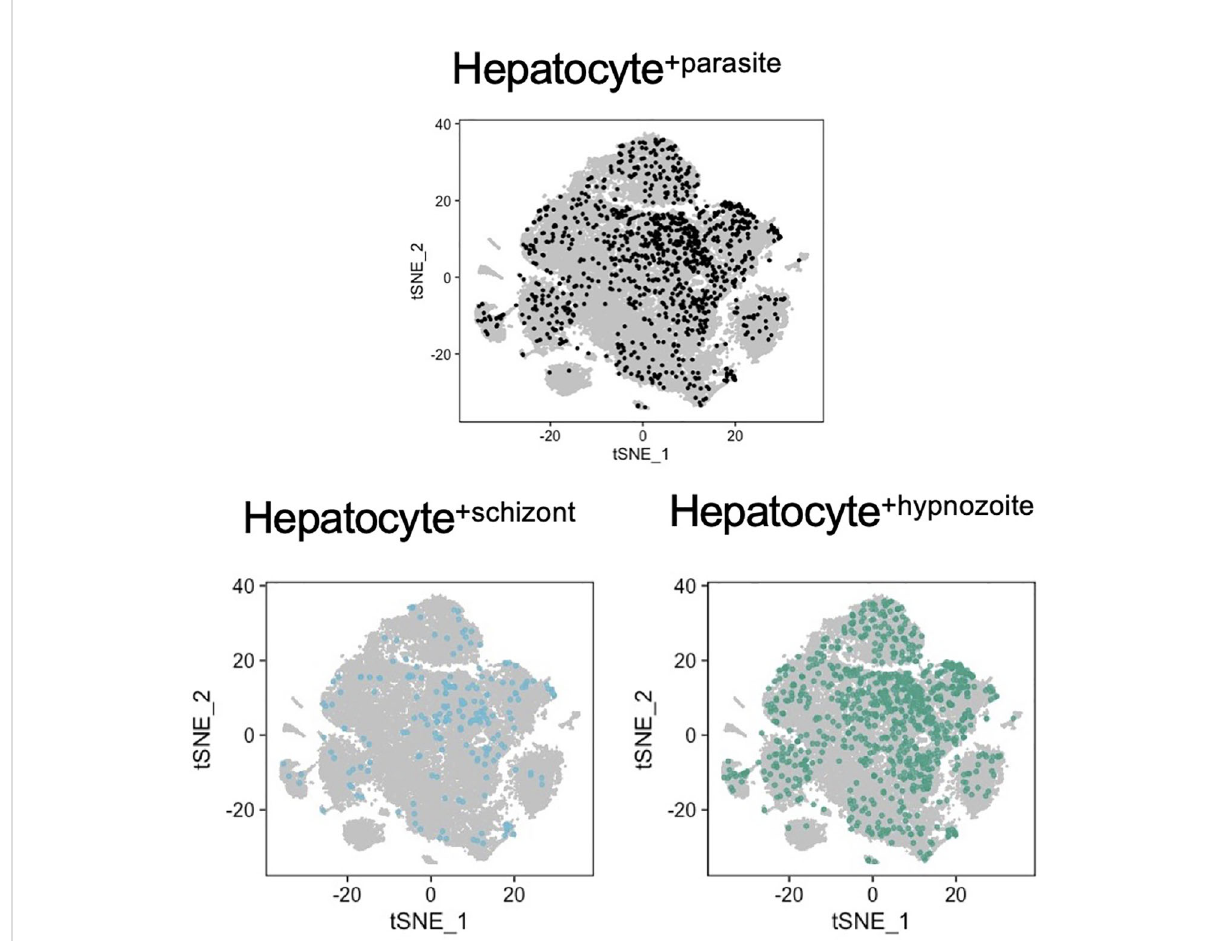
FIGURE 5 Analysis of host-pathogen transcriptional signatures in P. vivax - infected and non-infected hepatocytes. t-SNE plots of hepatocytes are faceted by infection status. Grey, noninfected (naive and exposed) hepatocytes; light blue, hepatocytes infected with schizonts; teal, hepatocytes infected with